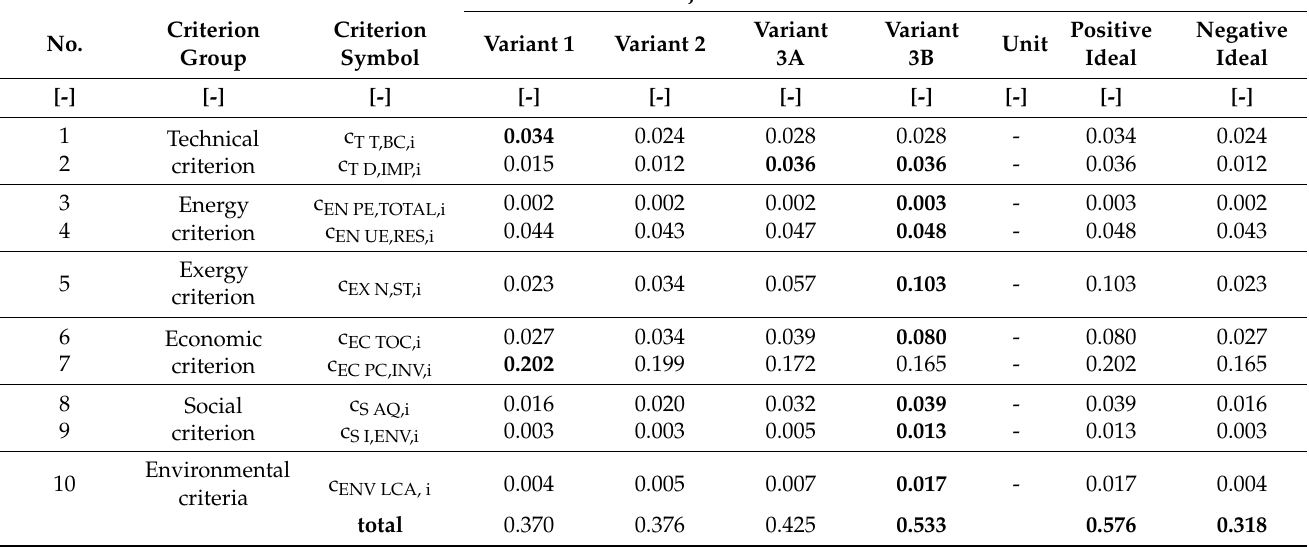
Table 9. Adjusted scores in the evaluation criteria for individual variants: The ‘economic preference’